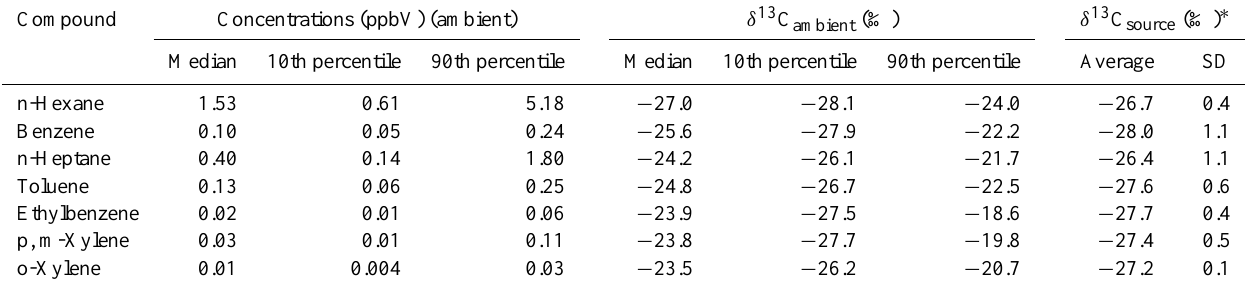
Table 4. Concentrations and delta values determined from ambient samples collected at Egbert. Compound Concentrations (ppbV)